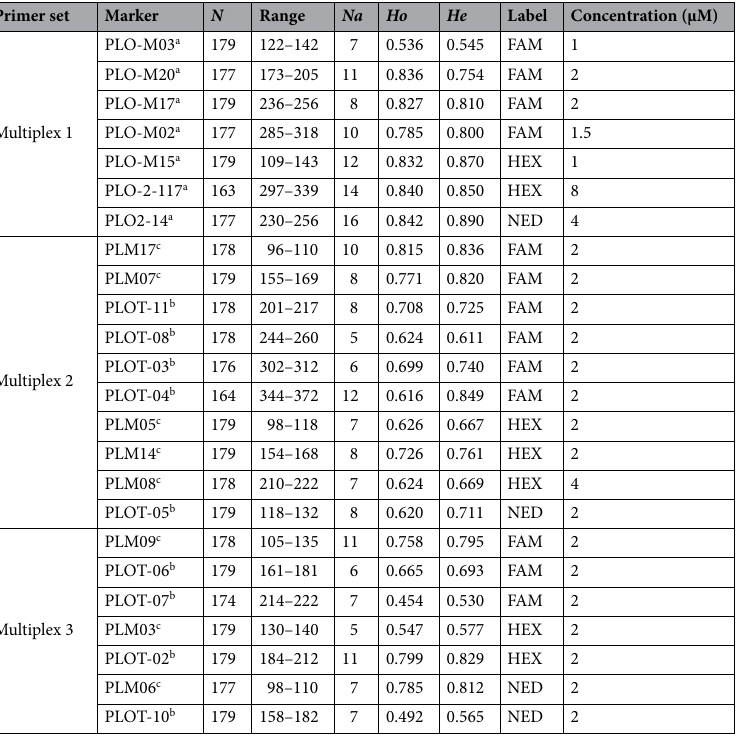
Table 1. Characteristic of the microsatellite 24 locus and primer sets of multiplex PCR. N number of the samples, Range range of the alleles, N number of the alleles, Ho observed heterozygosity, He expected heterozygosity, Label Primer Dye, Concentration (μM) Concentration of the primer in multiplex PCR. a Cullingham et al. (2006) 29 . b Fike et al. (2007) 30 . c Siripunkaw et al. (2008) 31 .